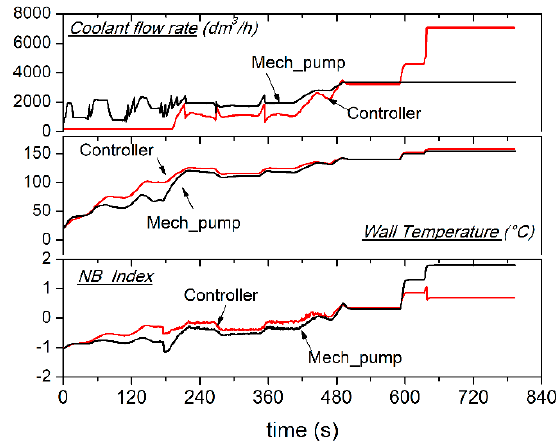
Figure 25. Coolant and wall temperatures for prolonged high load operation ( m(cid:4662) (cid:2916) = 18 kg/h).